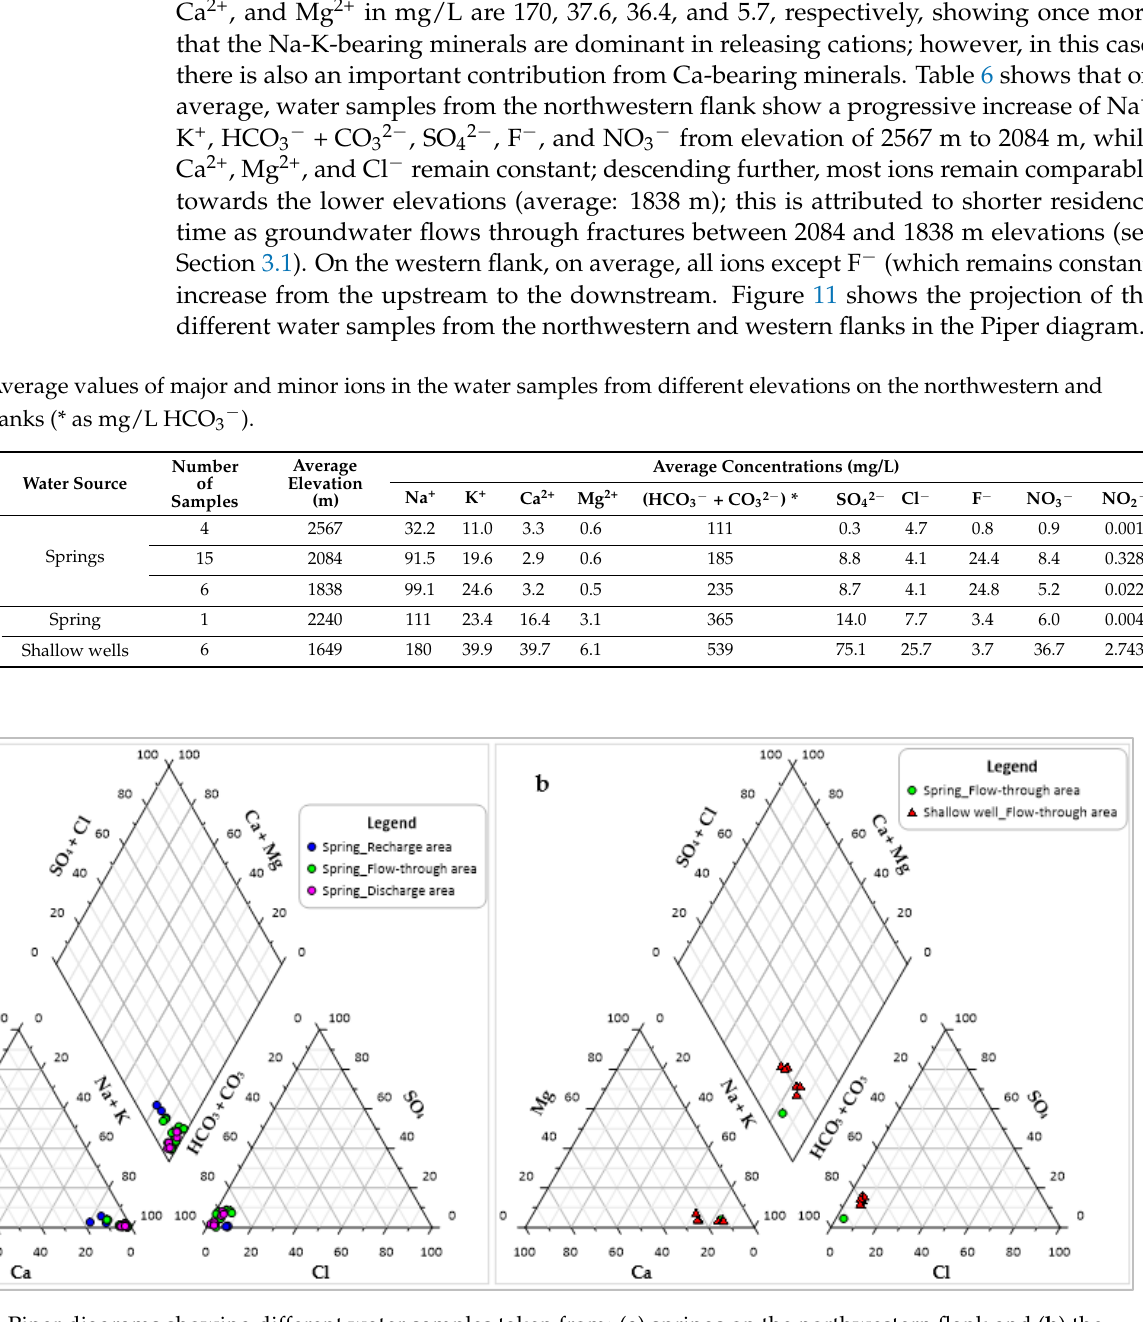
Figure 11. Piper diagrams showing different water samples taken from: ( a ) springs on the northwestern flank and ( b ) the spring and shallow wells on the western flank.